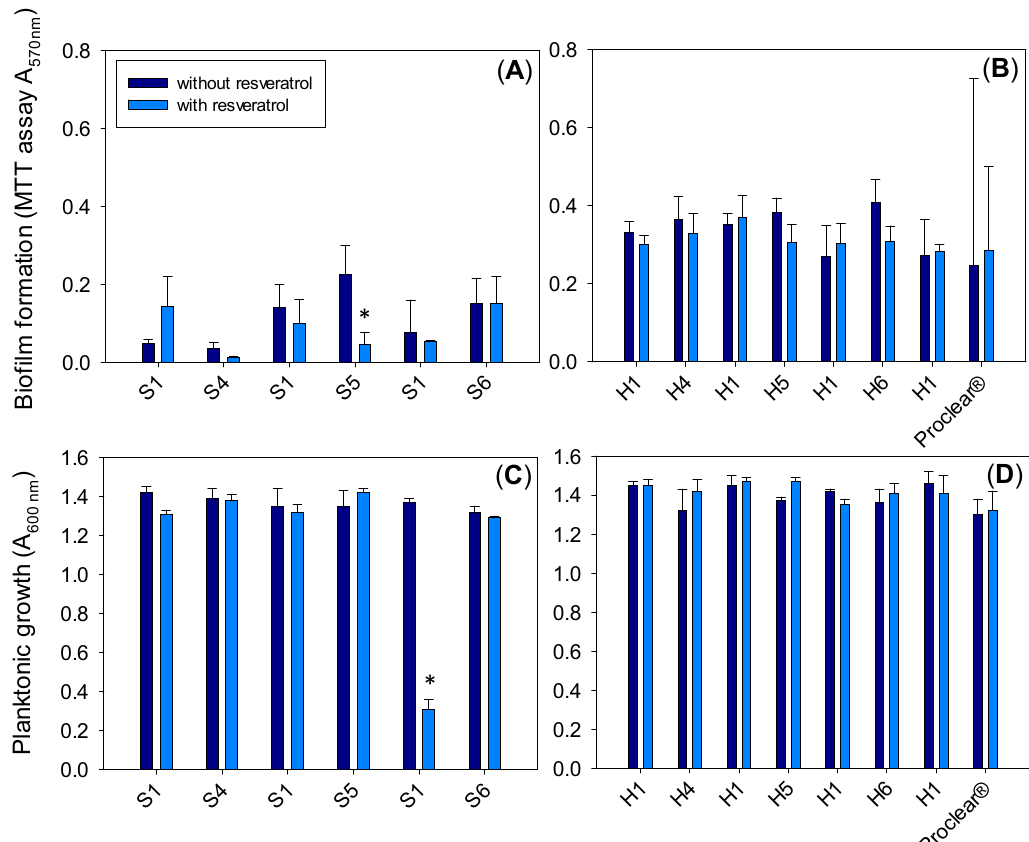
Figure 9. Growth of Staphylococcus aureus biofilm on the surface of silicone ( A ) and HEMA ( B ) hydrogels (without and with resveratrol) and in the medium surrounding the silicone ( C ) and HEMA ( D ) hydrogels (without and with resveratrol) after 48 h of incubation. In each experiment, a silicone hydrogel prepared with MPC (S4, S5 and S6) was evaluated in parallel to the silicone hydrogel without MPC (S1). Similarly, the HEMA hydrogels prepared with MPC (H4, H5 and H6) were evaluated in parallel to the HEMA hydrogel without MPC (H1). * indicates a statistically significant difference between hydrogels with and without resveratrol ( p < 0.05).